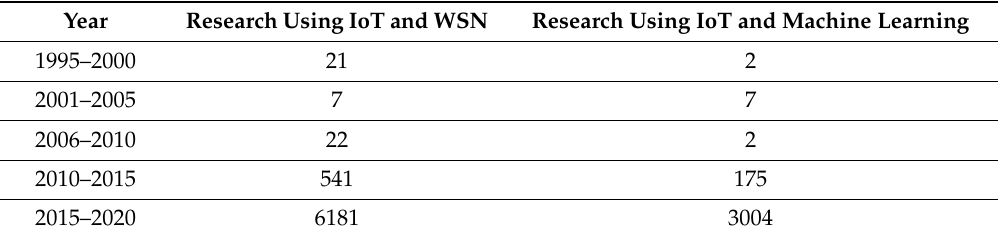
Table 5. Quantum of research contributions using IoT and WSN; and IoT and machine learning. Year